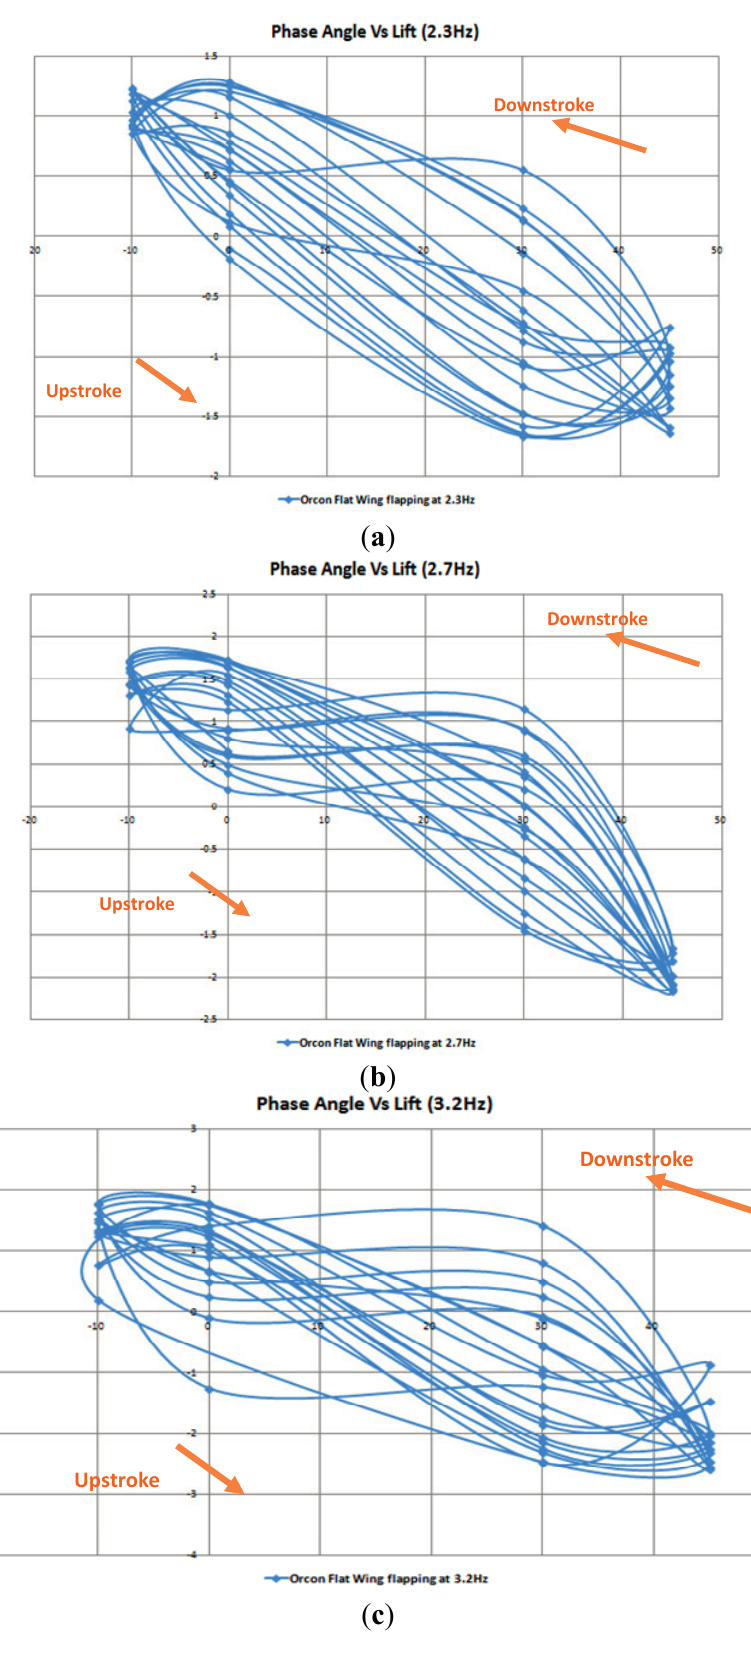
Figure 44. Phase angle vs . lift for Orcon flat wing. ( a ) Low speed; ( b ) medium speed; ( c ) high